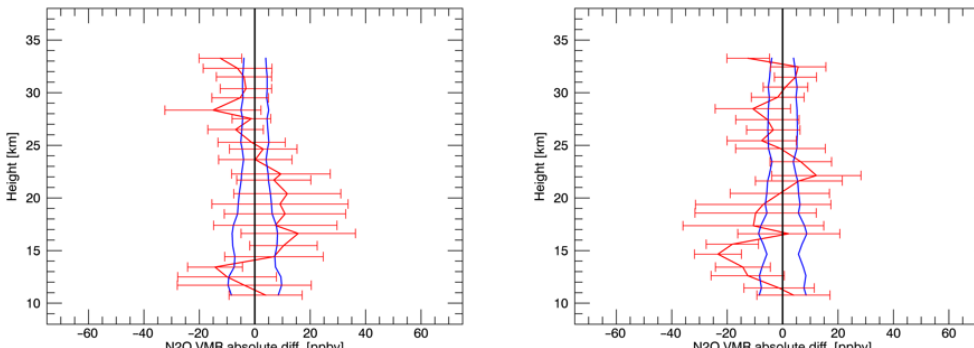
Figure 9. Same as Fig. 5, but instead of CH 4 now N 2 O.